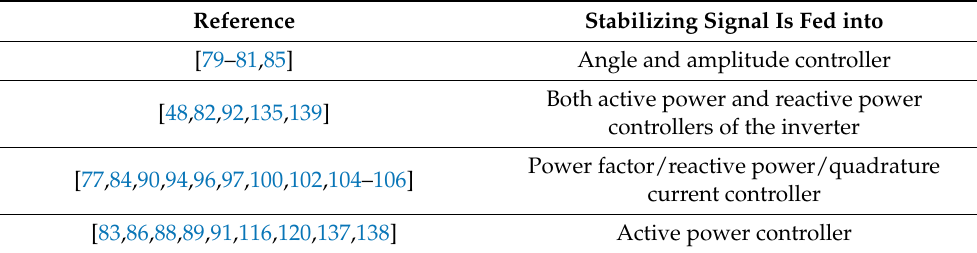
Table 3. The POD signal destination.